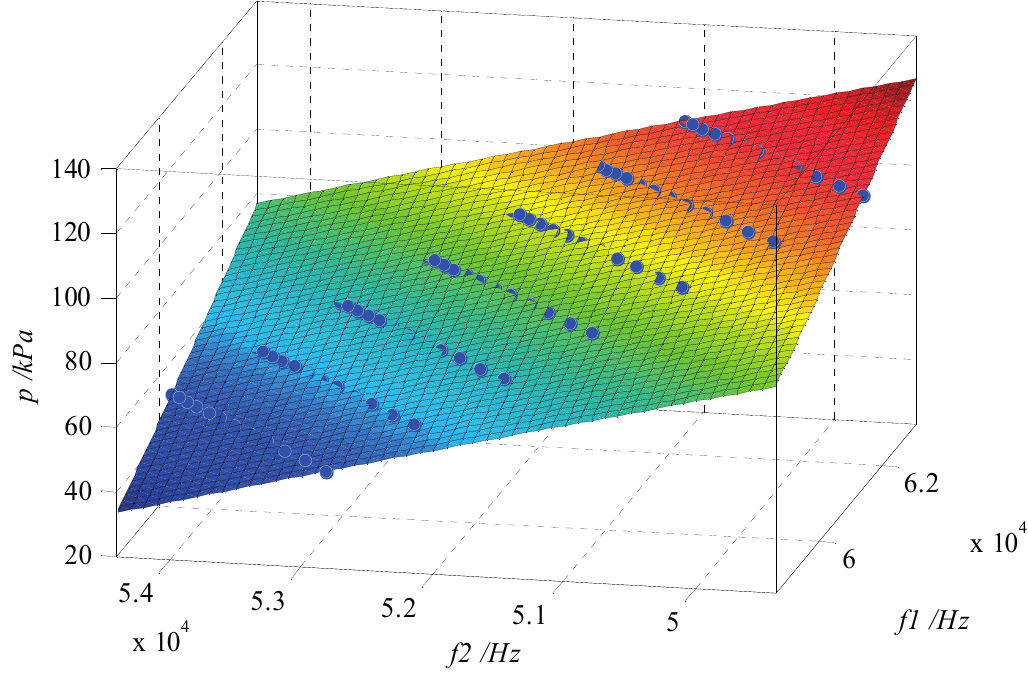
Figure 3. Surface plot of calculated pressure values obtained after cubic polynomial surface fitting as a function of two resonant frequencies f 1 and f 2 . The blue dots indicate the calibration